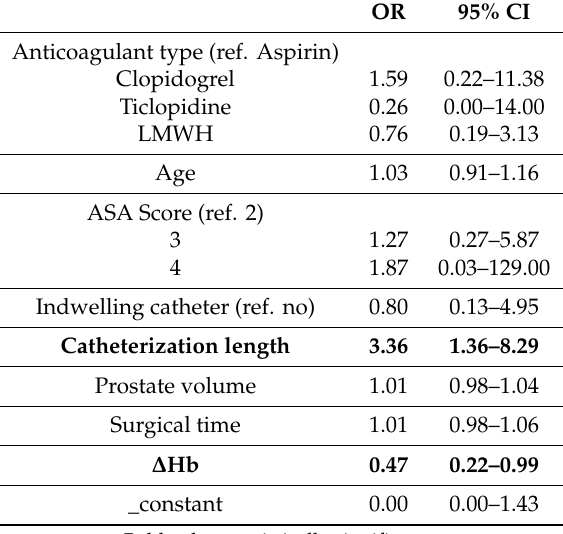
Table 3. Logistic regression (independent variable: at least one complication).